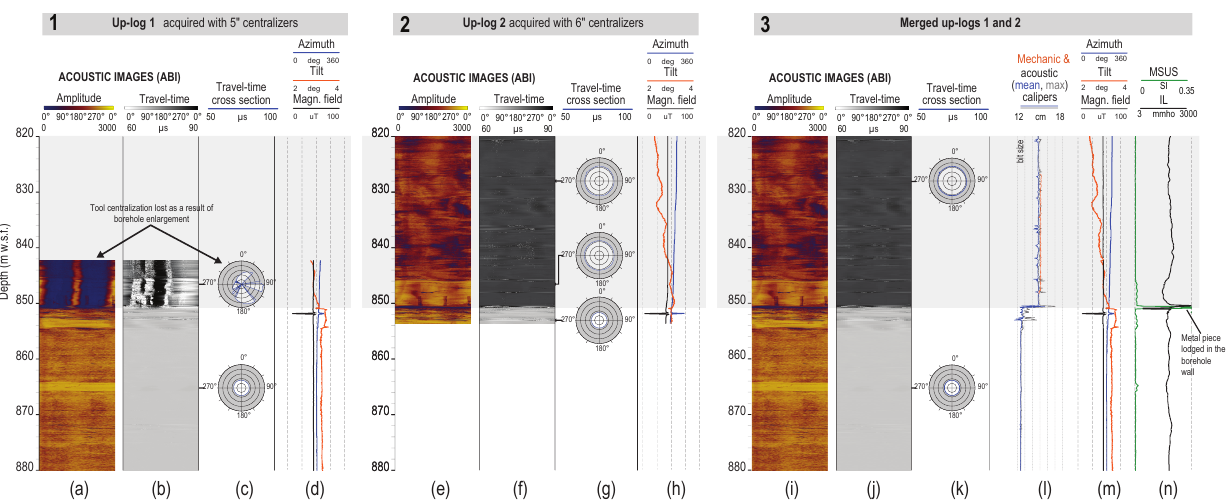
Figure 4. Drilling induced borehole enlargement as a result of fallen metal pieces (see discussion in Sect. 4.3). (1) Up-log 1; (2) Up-log 2; (3) merged Up 1 and Up 2 logs. Change in borehole diameter is evidenced at ∼ 850mw.s.f. by acoustic borehole image data (b, f, j, l) . The presence of steel pieces lodged in the borehole wall at the same depth is highlighted by azimuth, magnetic field, magnetic susceptibility, and conductivity spikes (m, n) . Note that the travel-time cross sections’ lower limits have been set to 50µs (c, g, k) . mw.s.f. is meter wireline depth below seafloor.